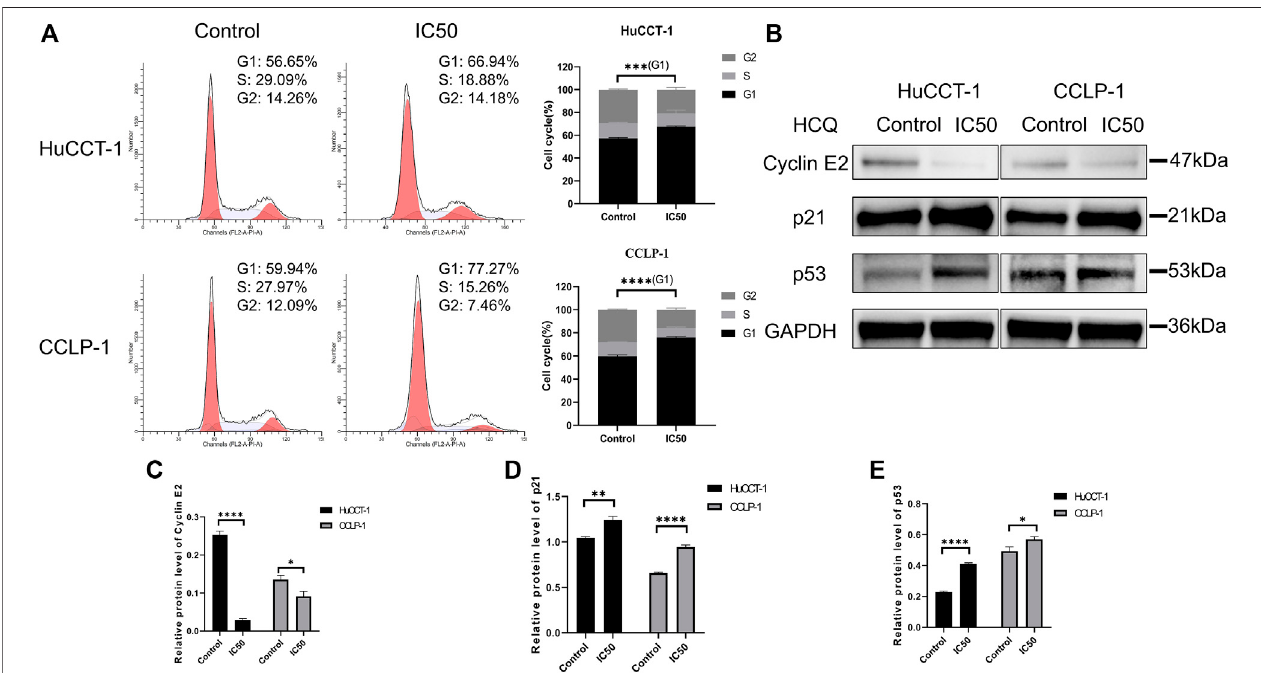
FIGURE 4 | HCQ induces cell cycle arrest in the G1 phase of cholangiocarcinoma cells. (A) FCM analysis was used to detect cell cycle distribution after treatment with the IC50 concentration of HCQ, the histograms show the percentage of HuCCT-1 and CCLP-1 cells in the G1-S-G2 phase, and the comparison of G1 phase between two groups was analyzed using Student ’ s t-test. (B) The G1 checkpoint proteins were analyzed by WB after treatment with the IC50 concentration of HCQ for 24 h. (C – E) Quanti fi cation of WB results of cyclin E2, p21, and p53. Data are shown as mean ± SD. * p < 0.05, ** p < 0.01, *** p < 0.001, **** p < 0.0001, signi fi cant difference compared with the control